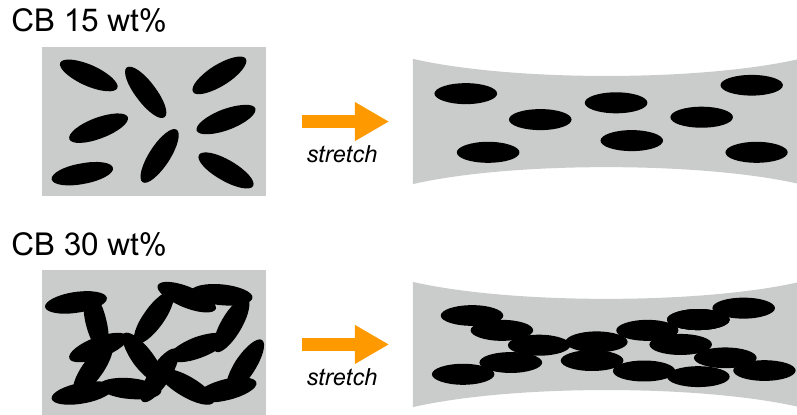
Figure 9. Illustration of the strain-induced change in the internal condition of SBR samples with CB amounts of 15 and 30 wt %.